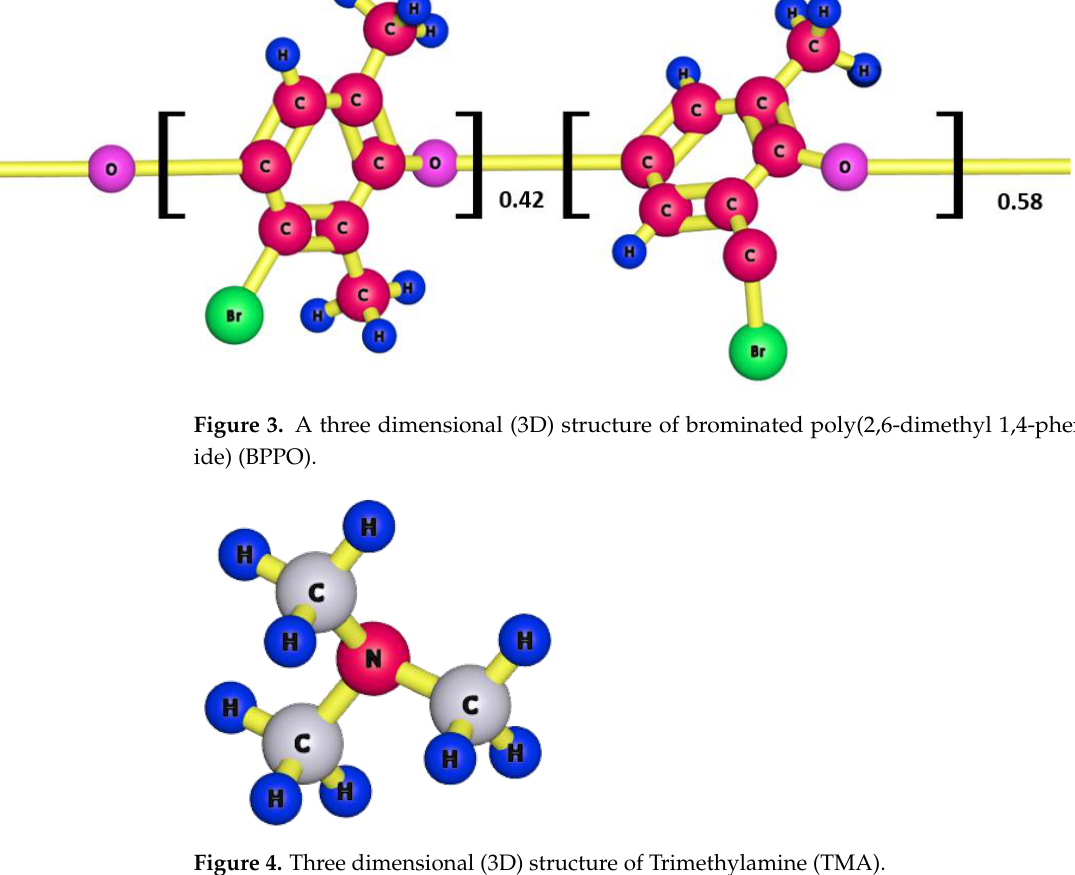
Figure 4. Three dimensional (3D) structure of Trimethylamine (TMA).